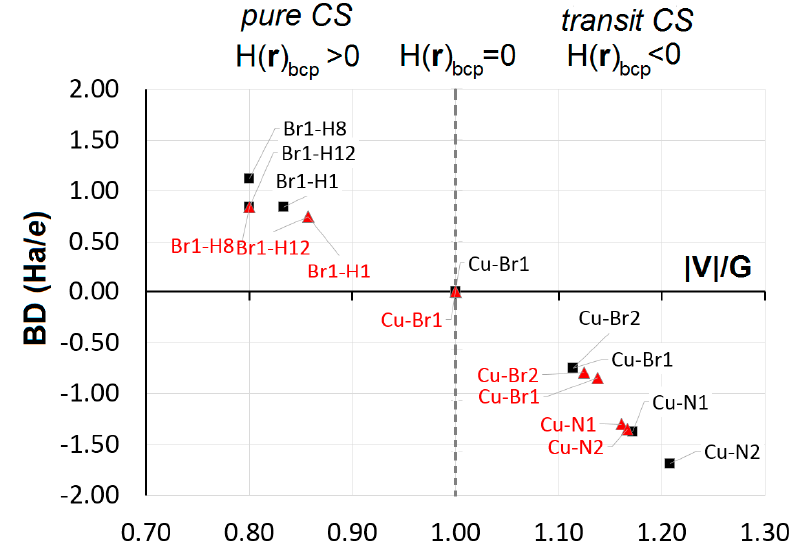
Figure 4. Bond degree parameter (BD = H ( r ) bcp / ρ ( r ) bcp , atomic units) vs. the adimensional ratio of potential and kinetic energy densities, | V ( r ) bcp |/ G ( r ) bcp , for chemical bonds in the valence coordination region of Cu 2 + . The | V ( r ) bcp |/ G ( r ) bcp = 1.0 boundary (dashed grey line) discriminates potential prevailing interactions ( H ( r ) < 0) from kinetic prevailing ones ( H ( r ) > 0). Black squares: experimental results. Red triangles: multipole-projected (F theo ) DFT estimates.